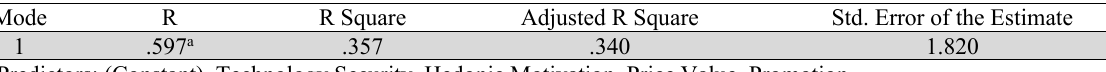
Result of Determination Coefficient Test